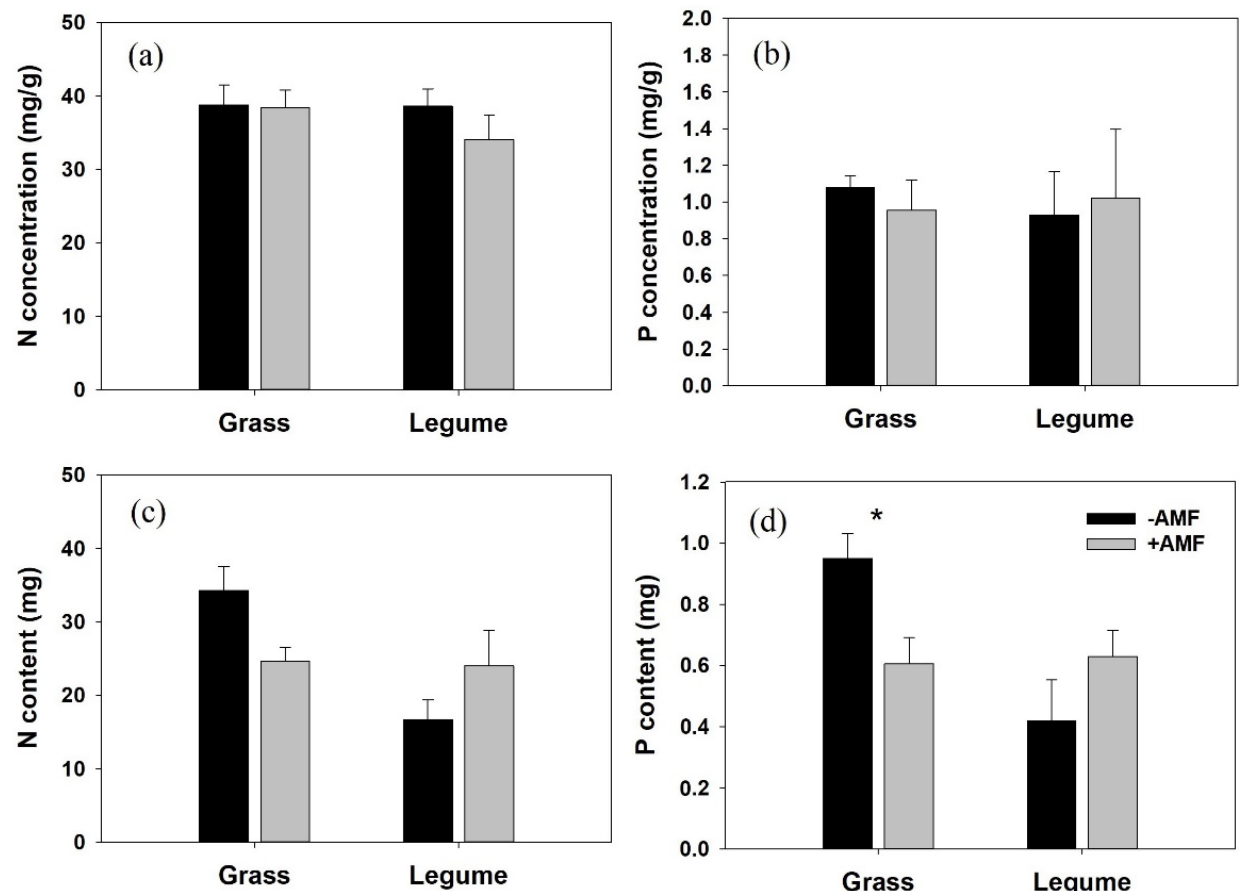
Figure 4. Nitrogen (N, ( a )) and phosphorus (P, ( b )) concentrations (mg/g) and contents (mg per plant, N, ( c ) and P, ( d )) in shoots of Pedicularis kansuensis . Data are presented as the mean ± standard error of three replicated pots. Significant differences (as determined by t test) between mycorrhizal (gray bars) and nonmycorrhizal (black bars) treatments are indicated by asterisks (* p < 0.05).